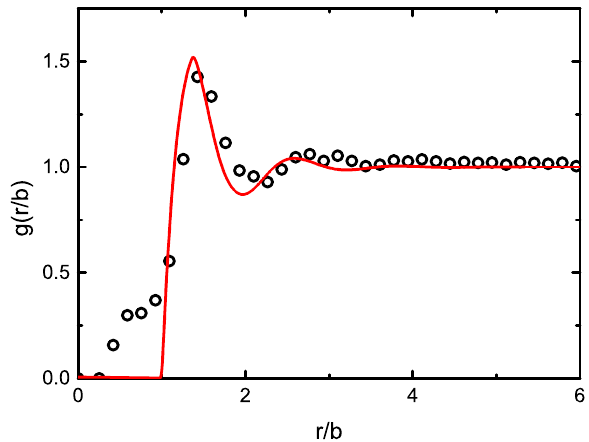
Figure A1. Experimental (open circles), radial distribution function g ( r ) of a fluid of PCPMMA ellipsoids, at φ = 0.11. The r -values of the experimental data are normalized by the minor axis of the ellipsoids b , which have been inflated to account for the non-hard interactions, as described in the text. The red curve is the theoretical g ( r ) of a fluid of hard ellipsoids, based on the Percus–Yevick approximation and fully described elsewhere [4,7].